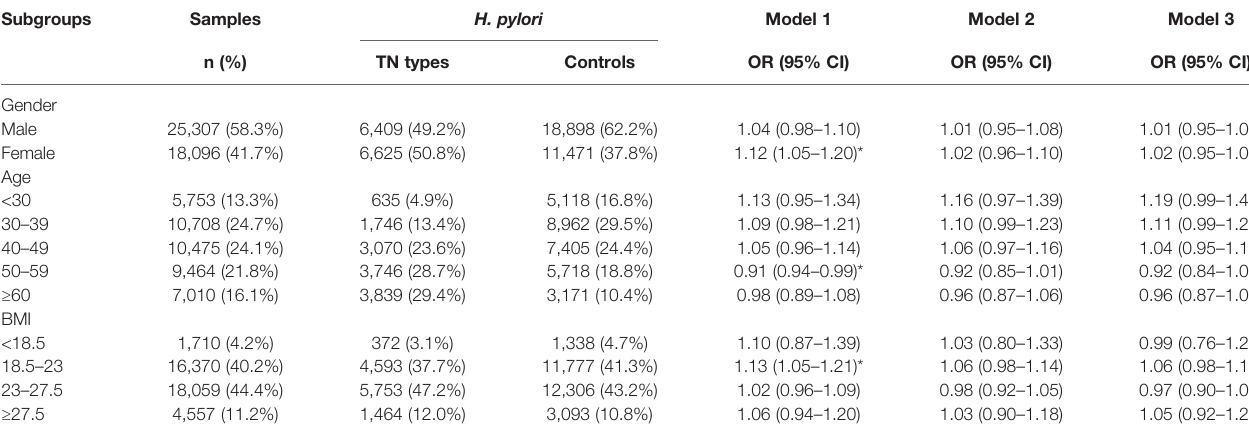
TABLE 3 | Subgroup analysis of H. pylori infection and the risk of TN types. Subgroups